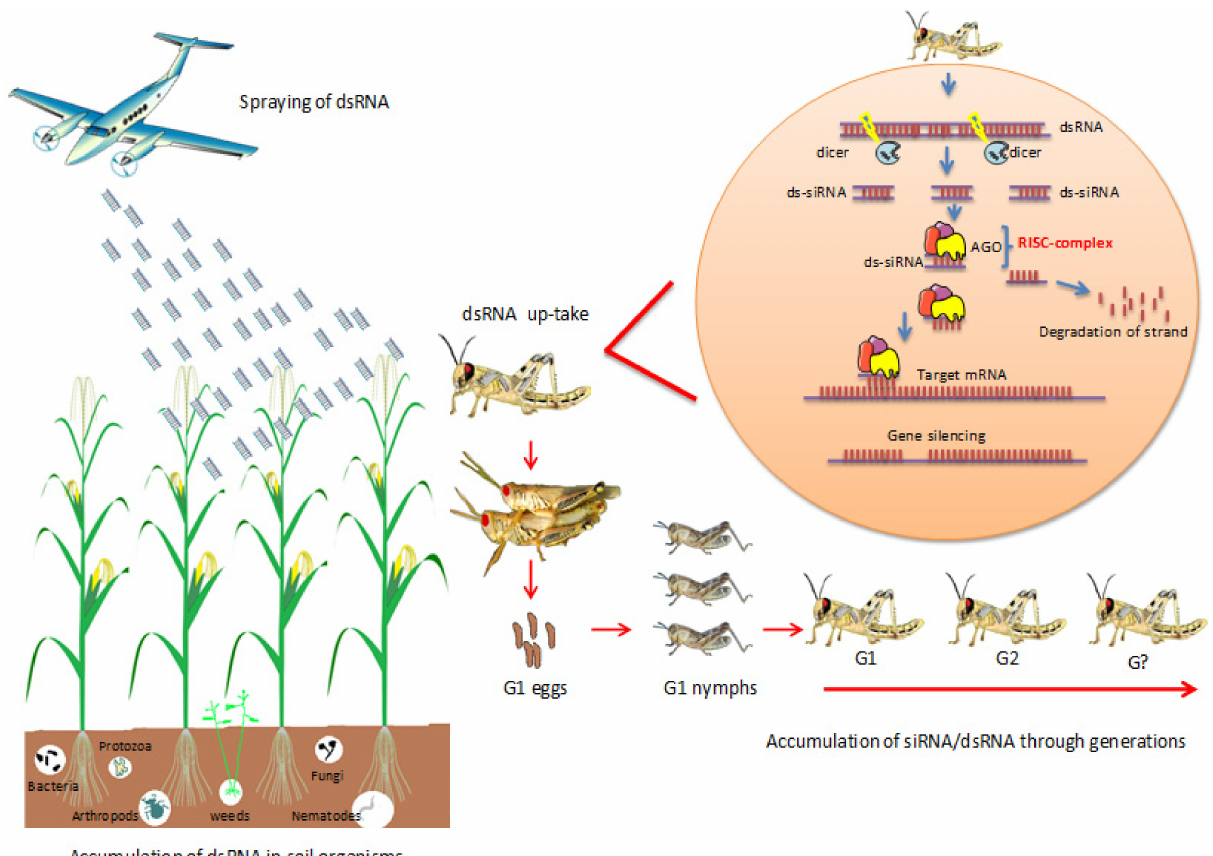
Figure 2. Predictable effect of dsRNA spraying on the long-term-insect transcriptome and soil living organisms’ behavior. The invasive insects take up the dsRNA directly or the plant-derived long dsRNA by sucking or chewing. In the insects’ cells, dsRNA process into 21 nt long siRNAs by the dicer (RNAse III enzyme). Produced siRNAs bind the RNAi-inducing silencing complex (RISC). The guide strand of siRNAs helps RISC to target the corresponding mRNA, leading to gene silencing and no protein expression. The siRNA silencing signals can remain for several